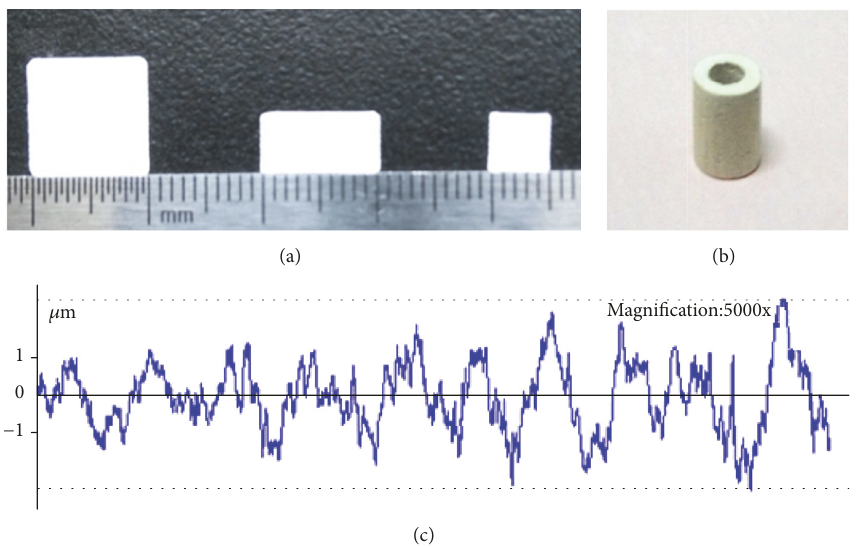
Figure 2: Printed LTCC samples and its roughness. (a) Substrates with different size. (b) Printed tubular specimen for dielectric testing. (c) Roughness of printed substrate.